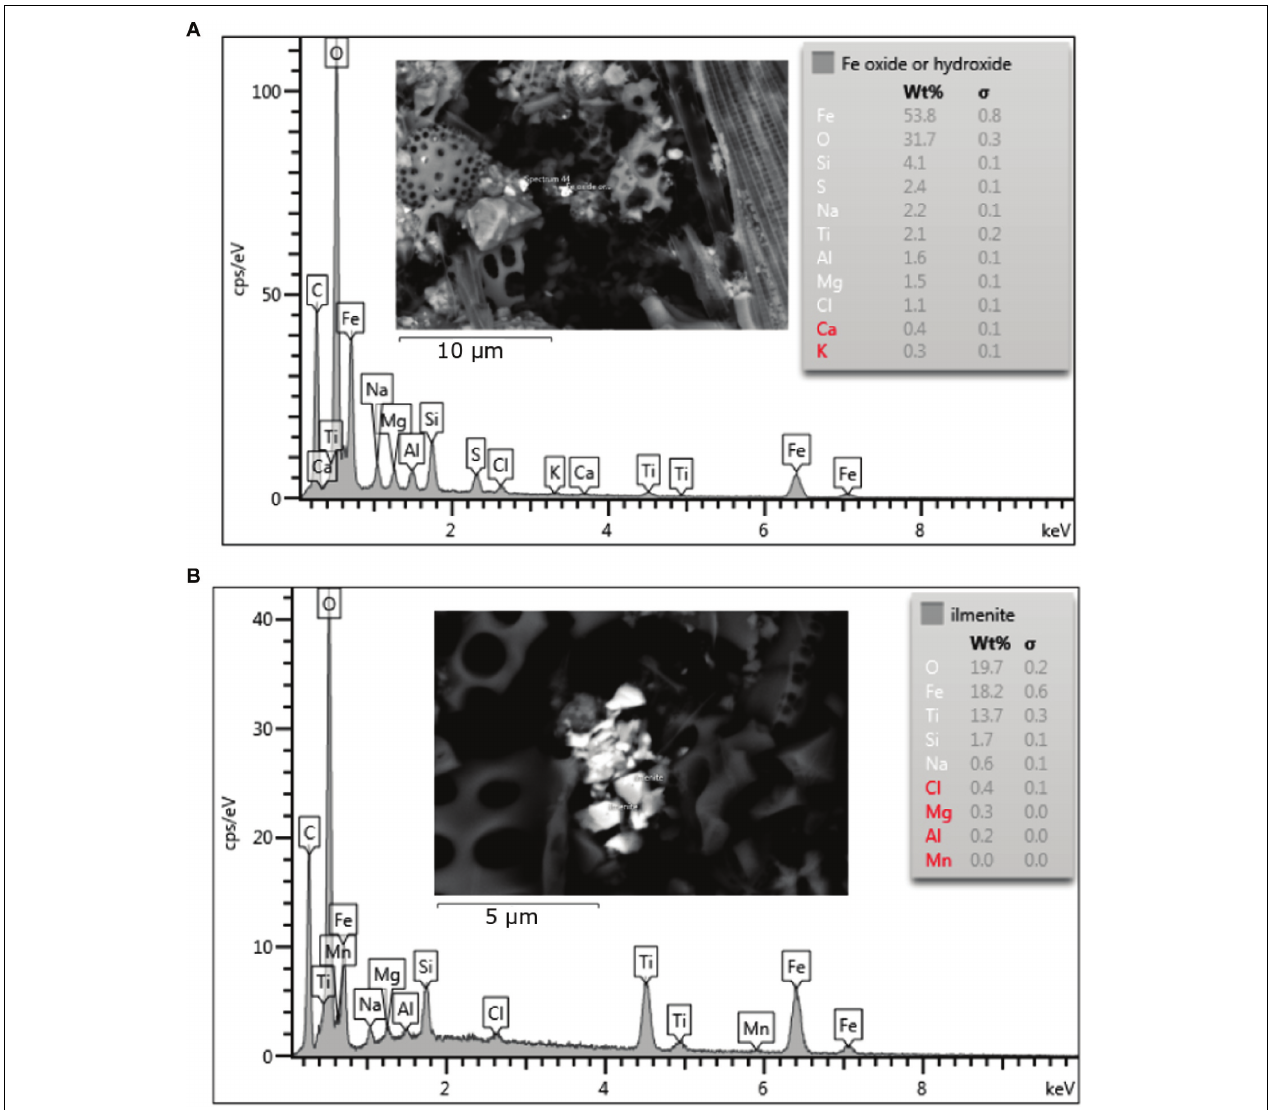
FIGURE 6 | Scanning Electron Microscope images and associated Energy-dispersive X-ray spectroscopy (EDS) spectrums showing elemental composition of the particles targeted. The spectra are representative of the particles inferred to be Fe oxyhydroxides (A) or ilmenite (B) . Red highlighted elements indicate uncertain